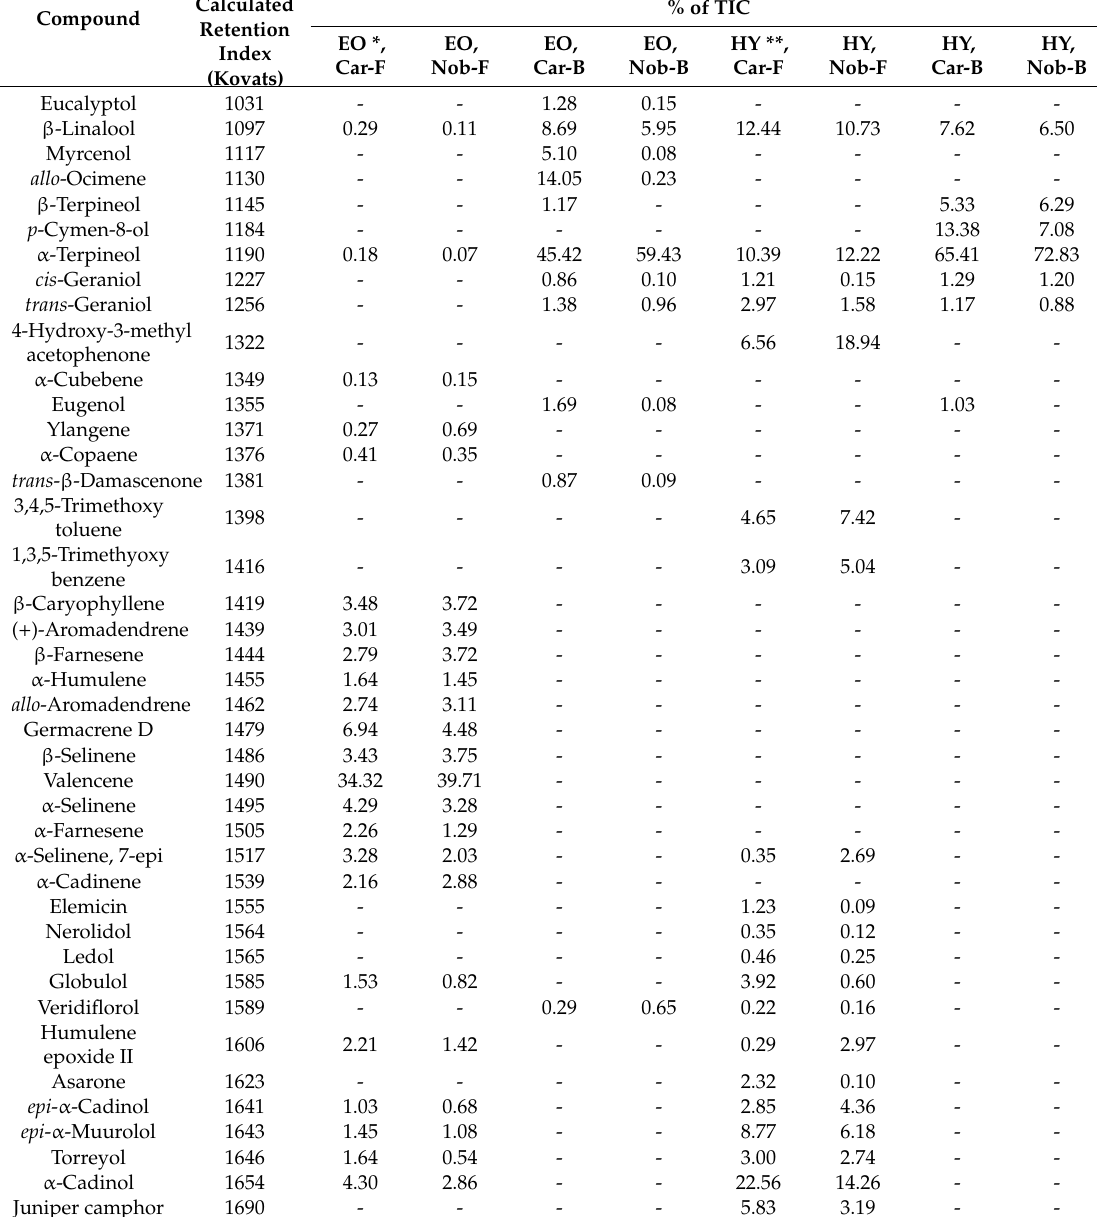
Table 1. Chemical composition of essential oils and hydrosols from two M. rotundifolia (Michx.) Small.